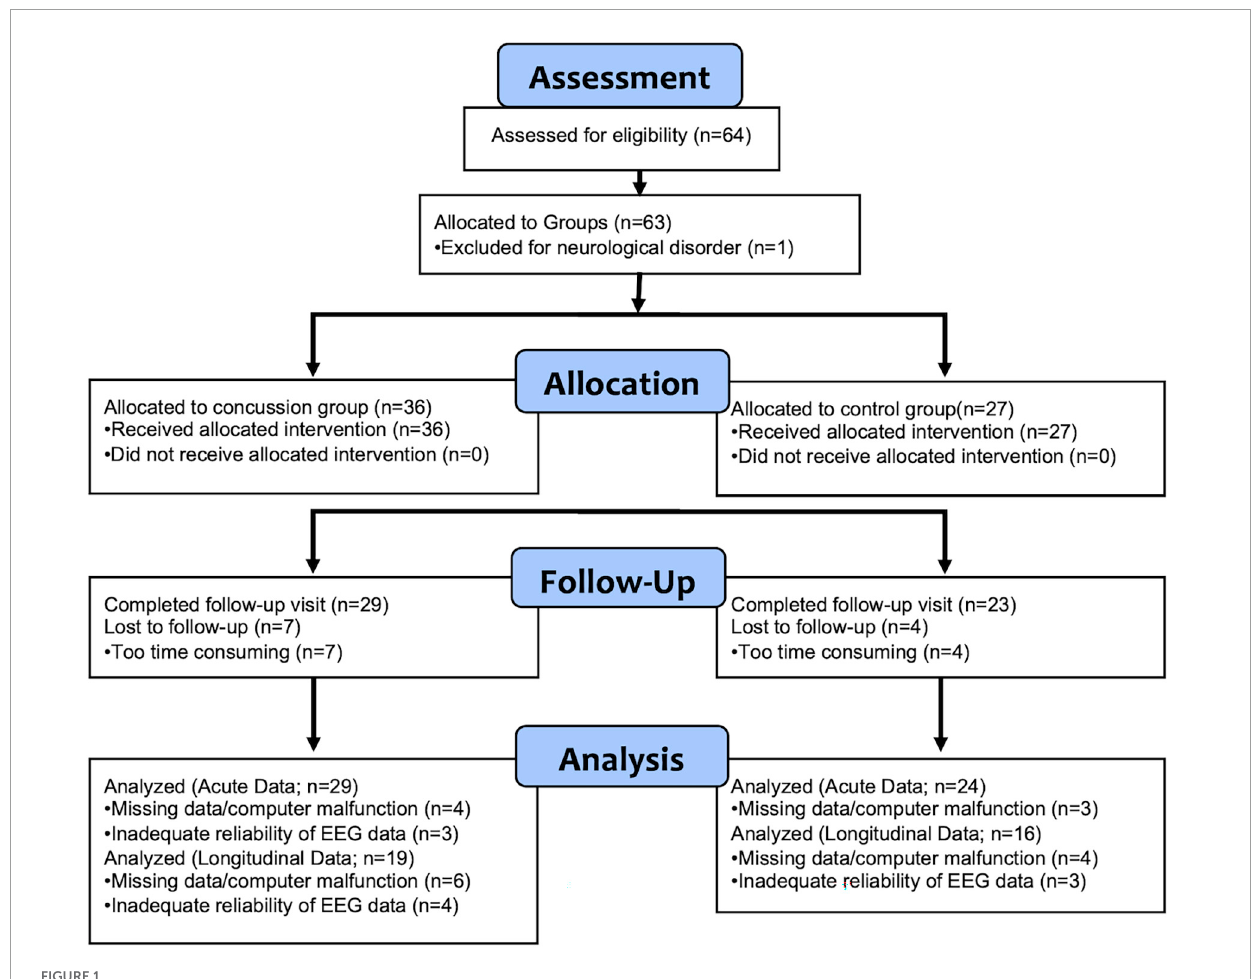
FIGURE1 Consort diagram for the study